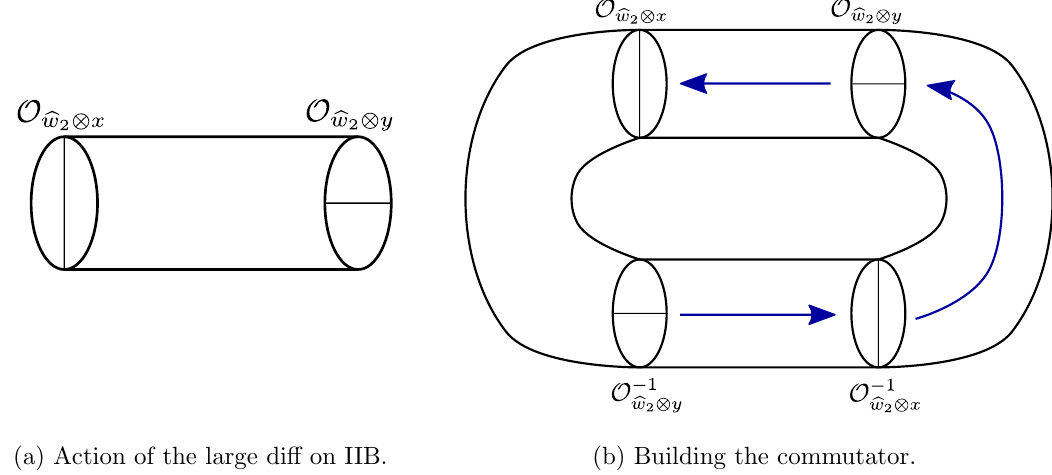
Figure 4. (a) The fractional instanton number can be viewed as the anomaly coming from a large di(cid:11)eomorphism in the presence background torsion (cid:13)ux. At the level of the (cid:13)uxes, this can be implemented by the insertion of suitable operators in the anomaly theory. (b) Gluing two copies of the con(cid:12)guration giving the anomaly to two con(cid:12)gurations without (cid:13)ux we obtain the anomaly theory with four operator insertions. Bringing the operators together we obtain the commutator, a